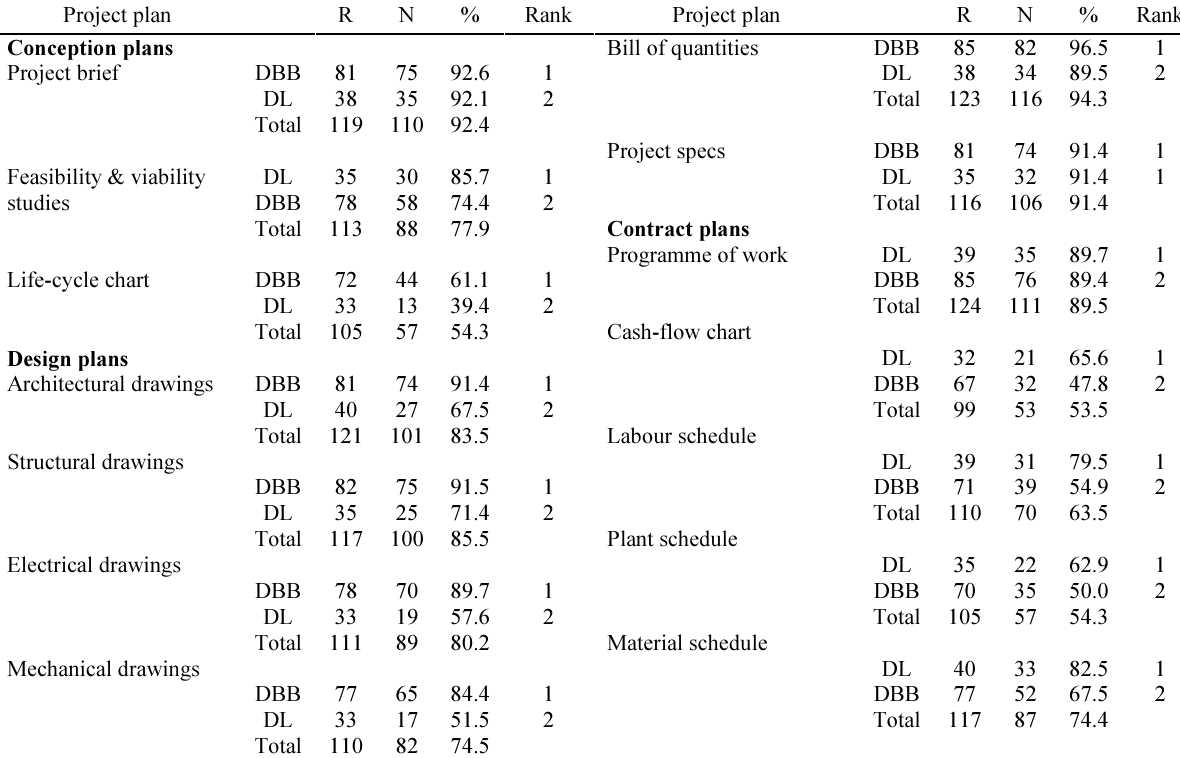
Table 3. Percentage of projects in which selected project plans were prepared Project plan